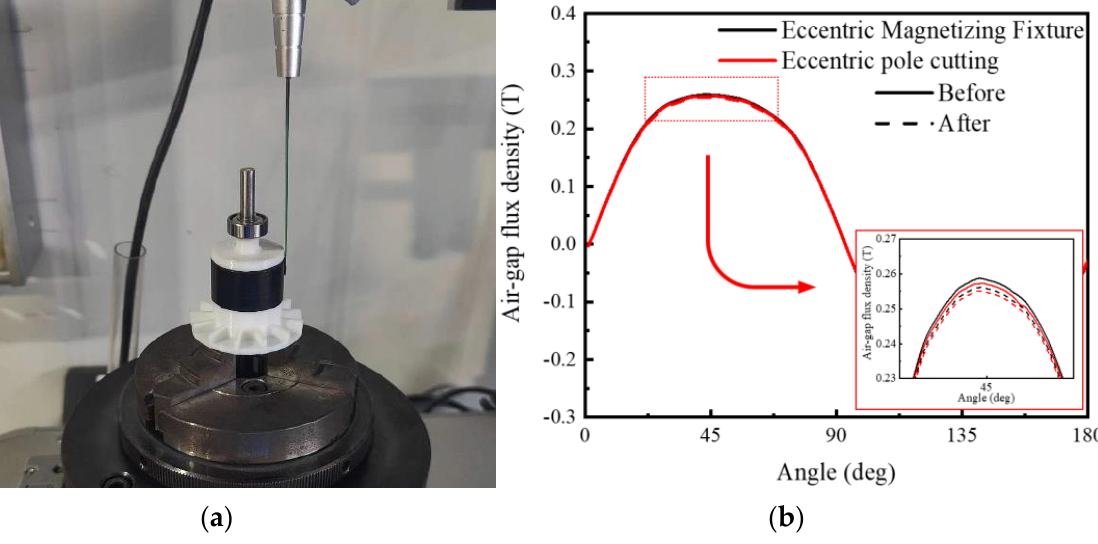
Figure 18. ( a ) Rotor test diagram. ( b ) Magnetic flux density distribution before and after demagnetization of the bonded magnetic ring rotor.